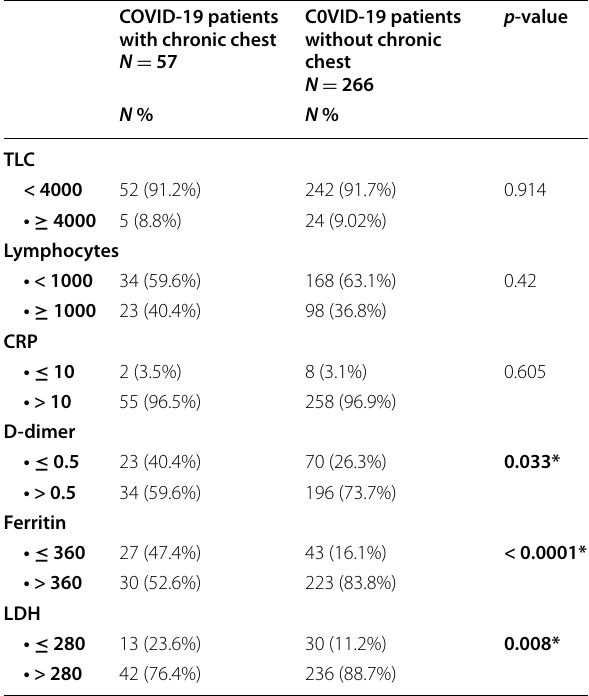
Table 4 difference in laboratory investigations between the two groups